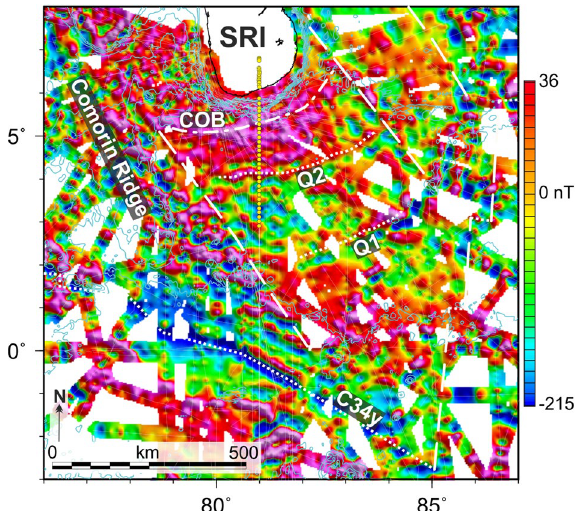
Figure 4. Compilation of our new magnetic data and all available regional shipborne magnetic data south of Sri Lanka (for line coverage see Supplementary Fig. S1). Map: Geosoft Oasis Montaj (https:// www. seequ ent. com/ produ cts- solut ions/ geoso ft- oasis- montaj/). Grey lines indicate the locations of newly acquired magnetic data between 5° N and 3° S (Fig. 1b), blue lines are selected bathymetric contours. The line spacing of the new shipborne data is approximately 20 km. Yellow circles show the positions of seismic stations along profile 20170300 (Fig. 2c) both on the seafloor and onshore Sri Lanka. See methods section for details of processing and gridding the magnetic data. Abbreviations: COB-continent-ocean boundary (onset of oceanic crust); Q1, Q2 and C34y—interpreted geomagnetic reversal and fluctuation intensity isochrons, age model according to 10,11,14